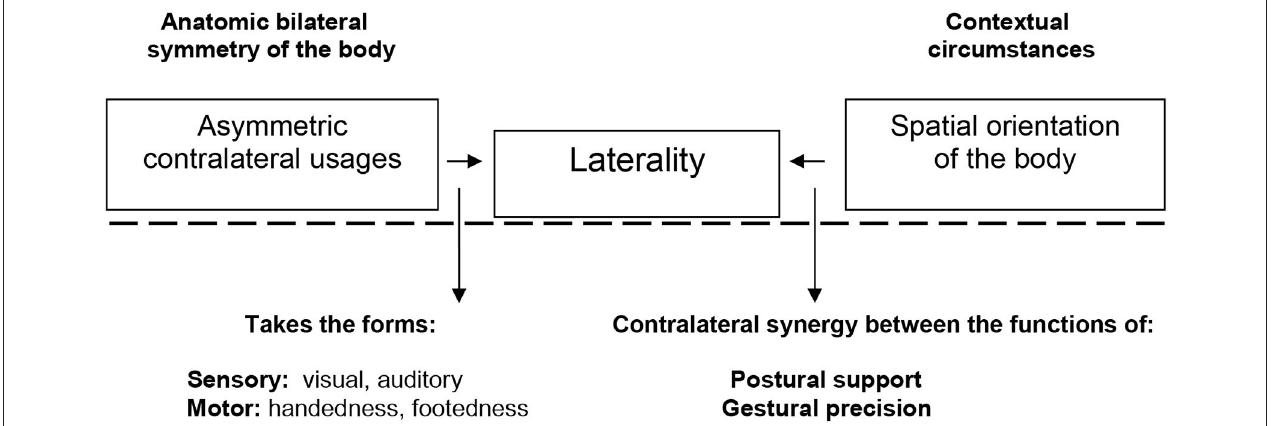
FIGURE 1 | Aspects involved in motor laterality